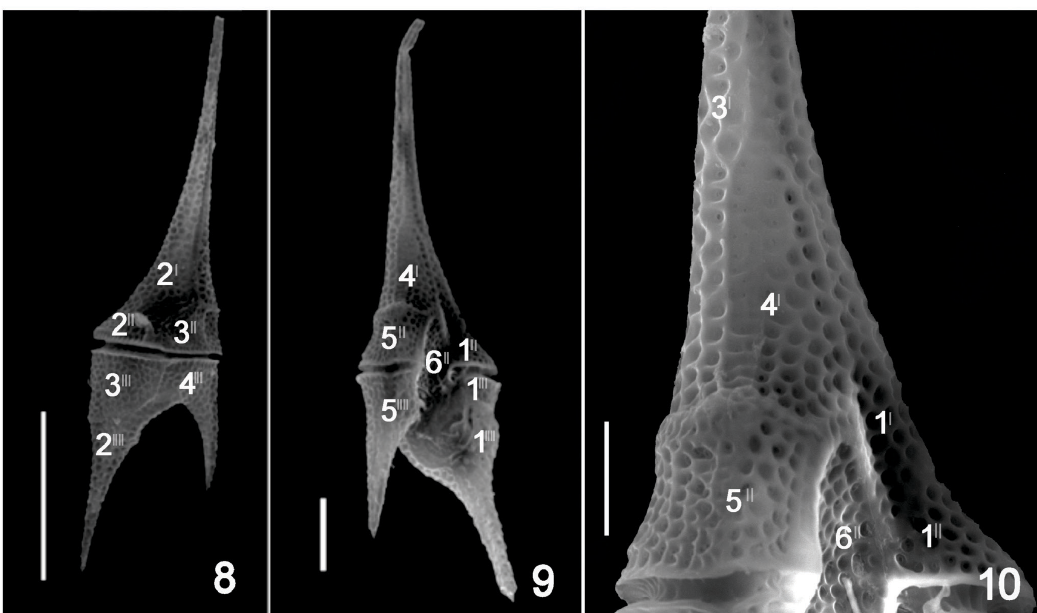
Figures 8-10. C. furcoides, population from Corumbá Reservoir, Goiás, in SEM. Figure 8: Cell in dorsal view showing the apical (2’), precingular (1” and 5”), postcingular (4”’ and 3”’) and antapical (2””) plates. Figure 9: Cell in ventral view showing the apical (4 ‘), precingular (1”, 5” and 6”), postcingular (1”’ and 5”’) and antapical (1””) plates; note the fourth apical plate (4’) not reaching the apex. Figure 10: Detail of epitheca in dorsal view. Scale bars: Figure 8 = 50 µm; Figure 9 = 20 µm; Figure 10 = 10